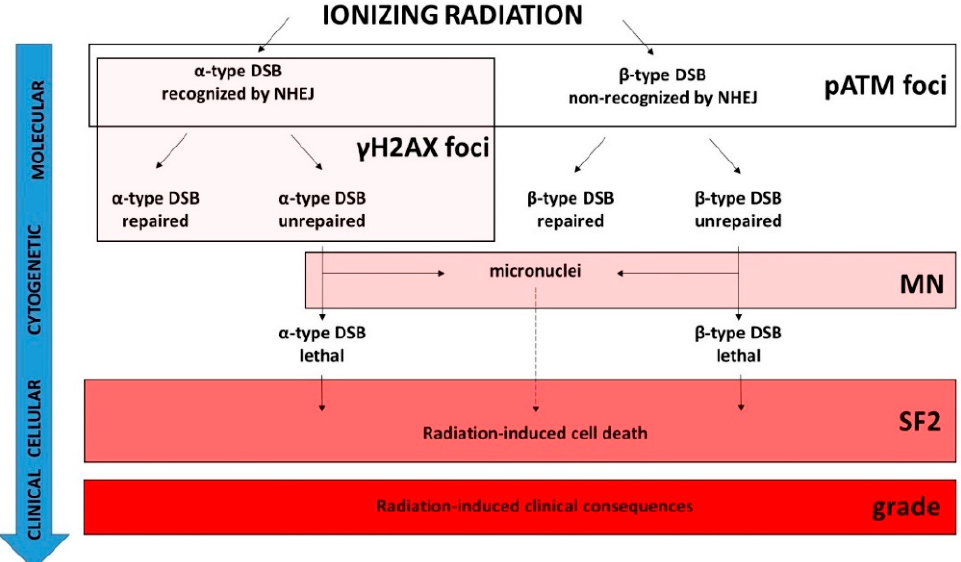
Figure 9. Schematic view of the molecular, cytogenetic, cellular, and clinical consequences of exposure to IR and the validity domain of the major radiosensitivity endpoints. IR induces two types of DSB. The α -type DSBs are recognized by the NHEJ DSB repair pathway while the β -type DSBs are not [49]. For each type of DSB, there are some subsets of unrepaired DSB [49]. Among them, some may be unrepairable and contribute to the lethal effect. Some unrepaired DSBs may also provide micronuclei according to the radiosensitivity status and the capacity of irradiated cells to bypass the G2/M arrest [15]. The pATM foci biomarker detects the DSBs recognized by NHEJ, and the DSBs non-recognized by NHEJ or recognized by another DSB repair pathway can be deduced from the induction rate of DSBs “physically” induced by IR. The γ H2AX foci biomarker detects the α -type DSBs only. Both α - and β -type unrepaired DSBs may provide some micronuclei, but the ratio between unrepaired DSBs and micronuclei is not necessarily equal to 1. Some subsets of micronuclei can contribute to the lethal effect. SF2 reflects all the RI cell deaths and therefore reflects the whole cellular response to IR independently of the DSB repair pathways involved. The dashed line indicates that the link is different from a one-to-one correlation.